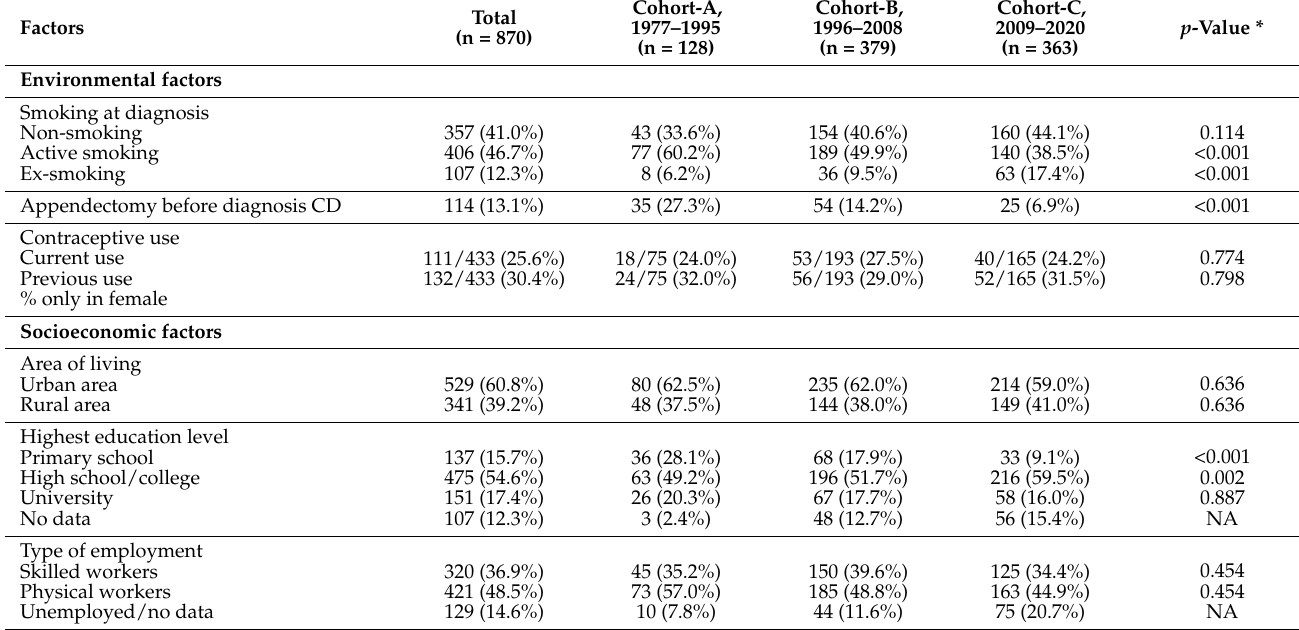
Table 3. Trend of environmental factors of 870 incident CD patients stratified by the eras of CD